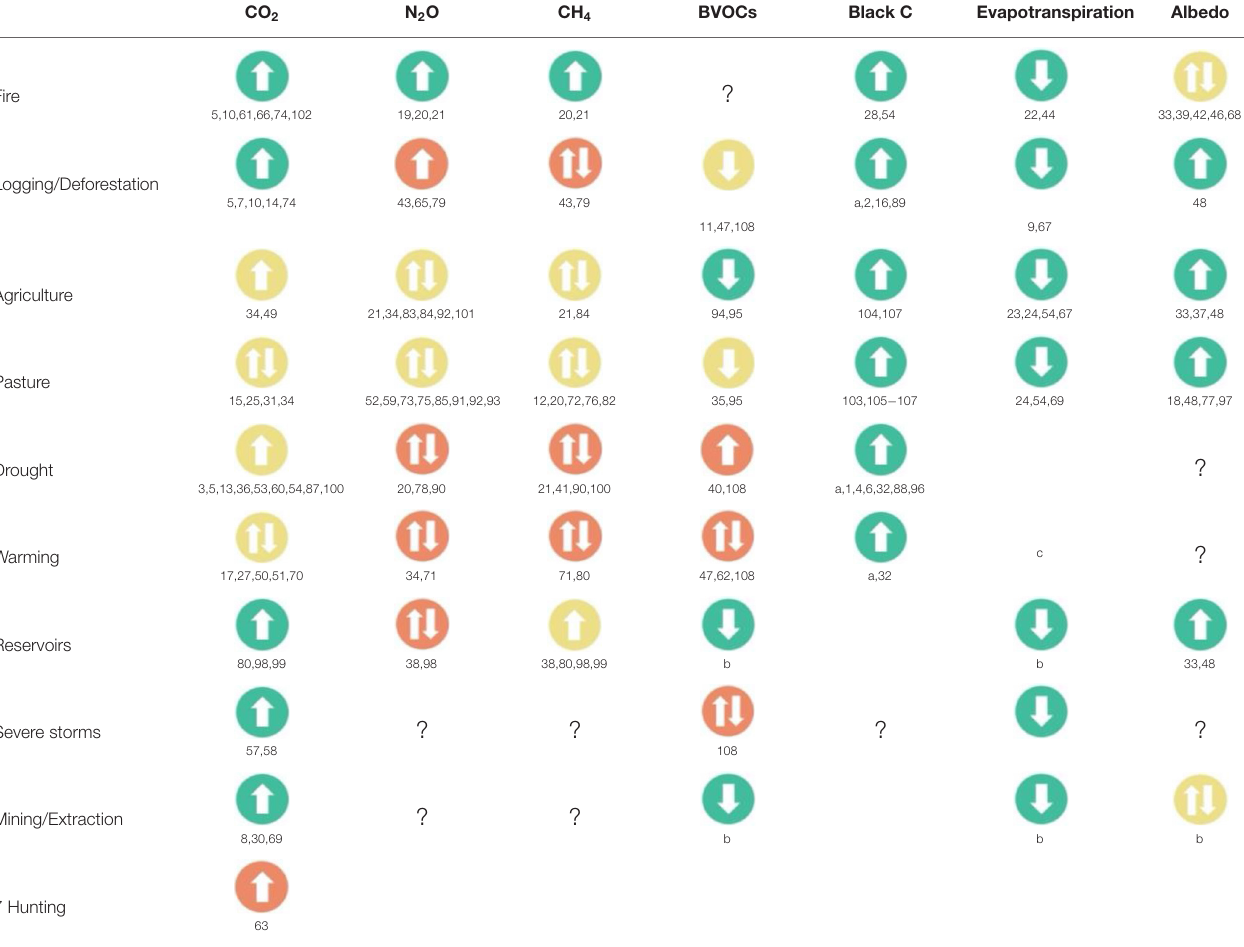
TABLE 2 | Expected direction of response to disturbance for climate forcing agents, associated confidence, and relevant literature